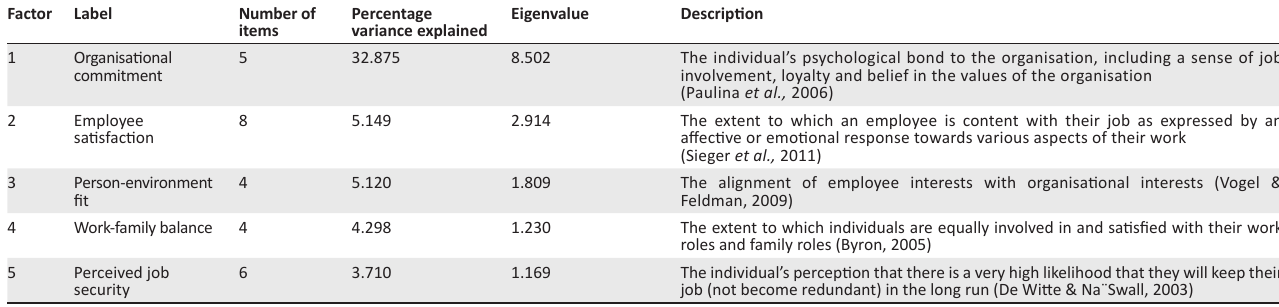
TABLE 2: Extracted work-related factors, employee satisfaction, organisational commitment and description of dimensions. Factor Label